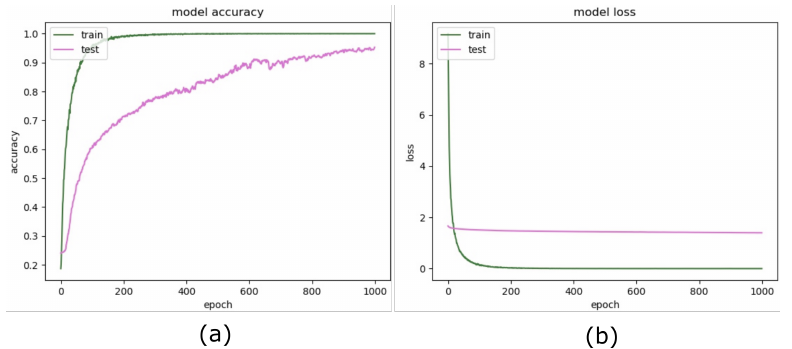
Figure 5. Minhas et al. training history. ( a ) Model accuracy, ( b ) Model loss.